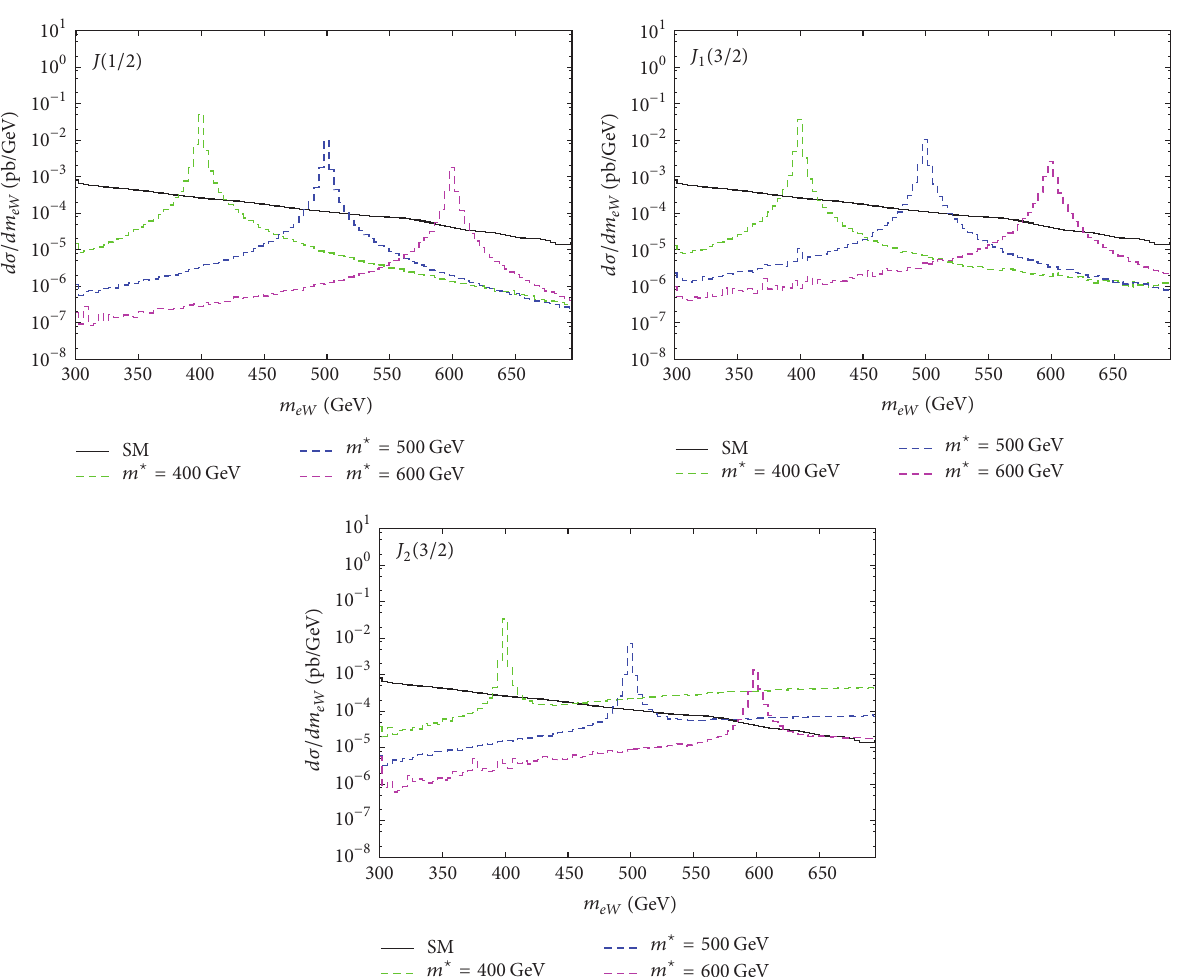
Figure 5: Invariant mass distributions of 𝑒𝑊 system for the single production of excited spin-1/2 for 𝑓 = −𝑓 󸀠 = 1 and excited spin-3/2 neutrinos with 𝐽 1 and 𝐽 2 for 𝑐 𝑖𝑉 = 𝑐 𝑖𝐴 = 0.5 ( 𝑖 = 1, 2 ) at √𝑠 = 1.3